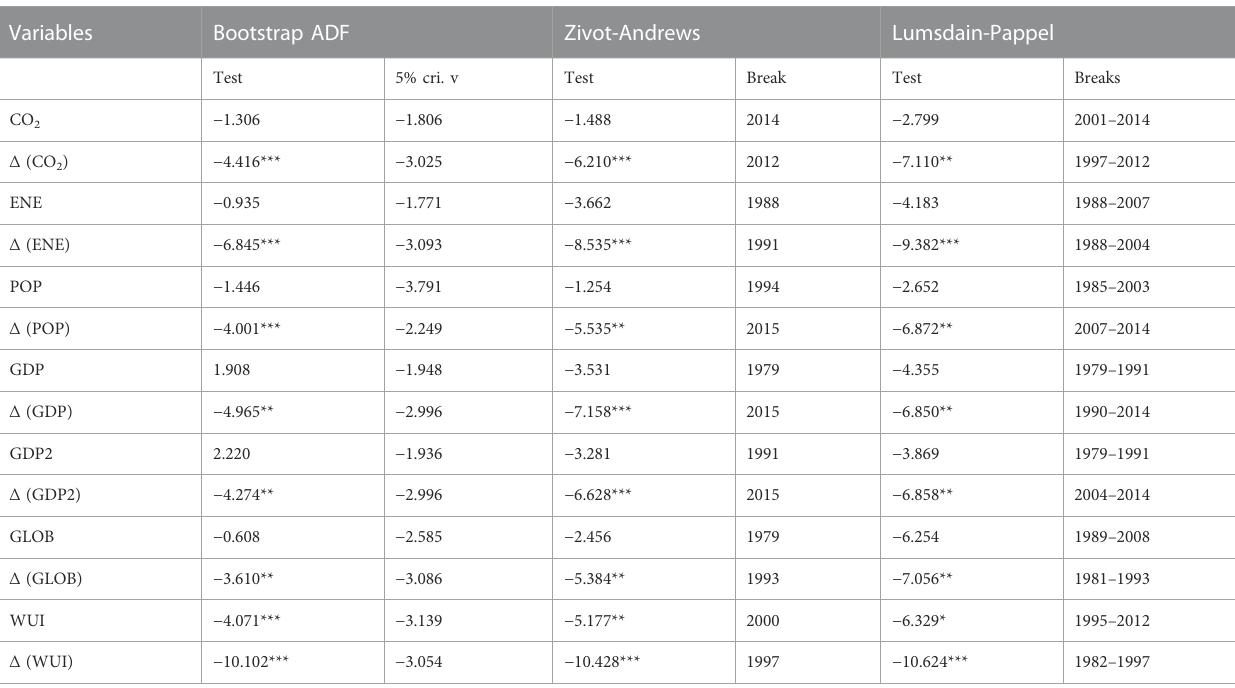
TABLE 1 Unit root tests results.